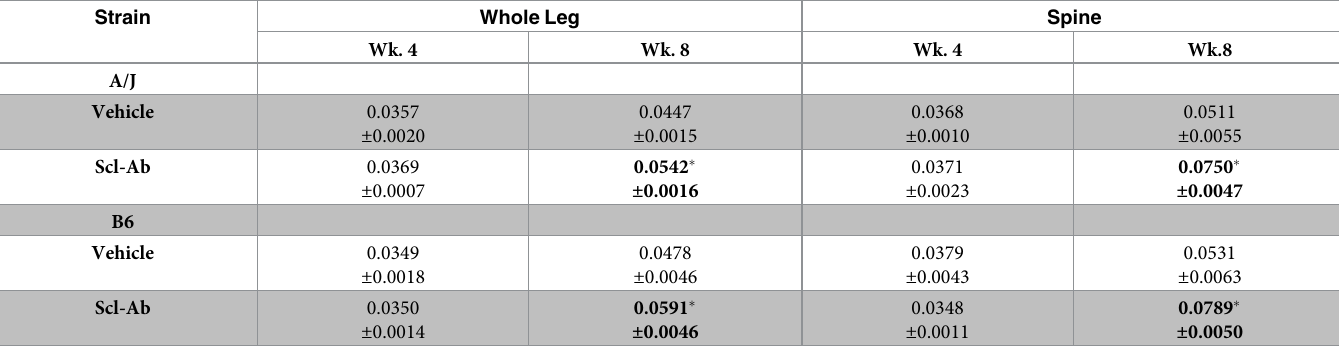
Table 2. Areal bone mineral density (aBMD) data from PIXImus scans of the whole leg and spine of A/J and B6 mice treated with Scl-Ab or vehicle. Scans were con- ducted prior to the start of dosing (4 weeks) and following the completion of dosing (8 weeks). Strain Whole Leg Spine Wk. 4 Wk. 8 Wk. 4 Wk.8 A/J Vehicle